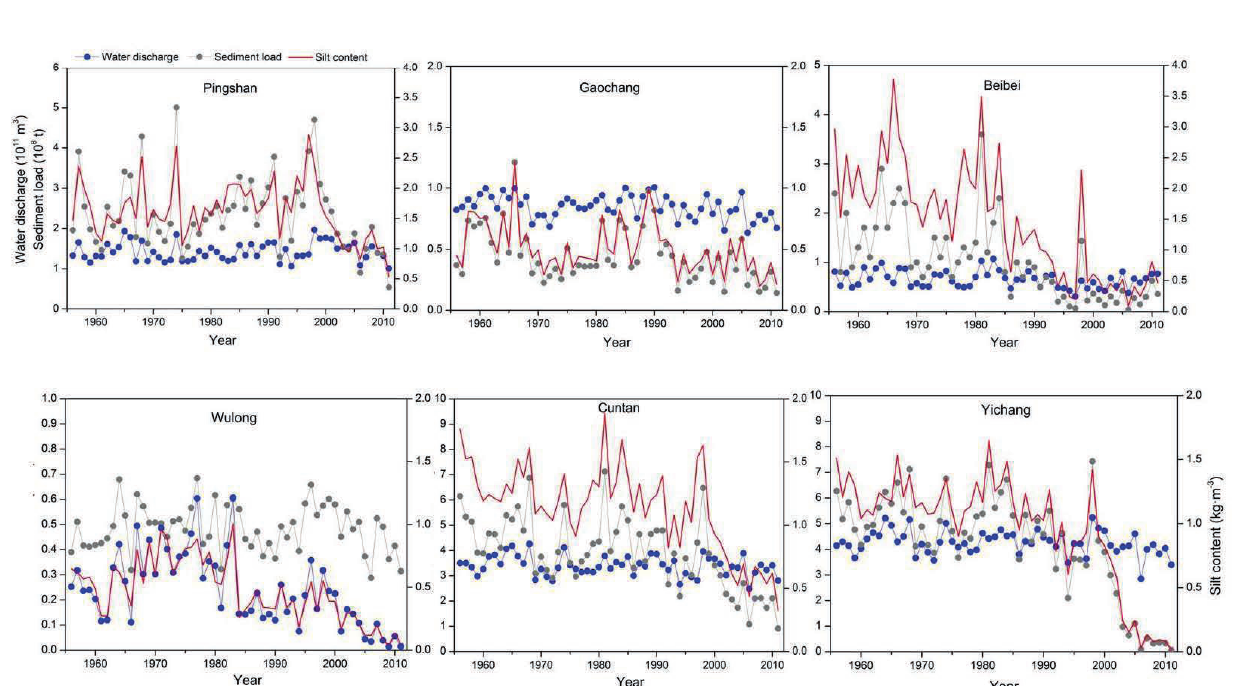
Fig. 2 The inter-annual variations of runoff discharge, sediment yield and silt content in Upper Yangtze River and its four major